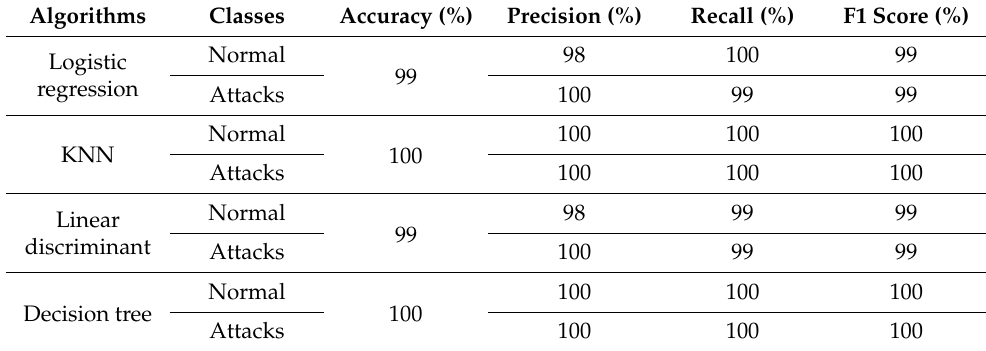
Table 6. Results of approaches in binary classification for detecting ICS attacks.